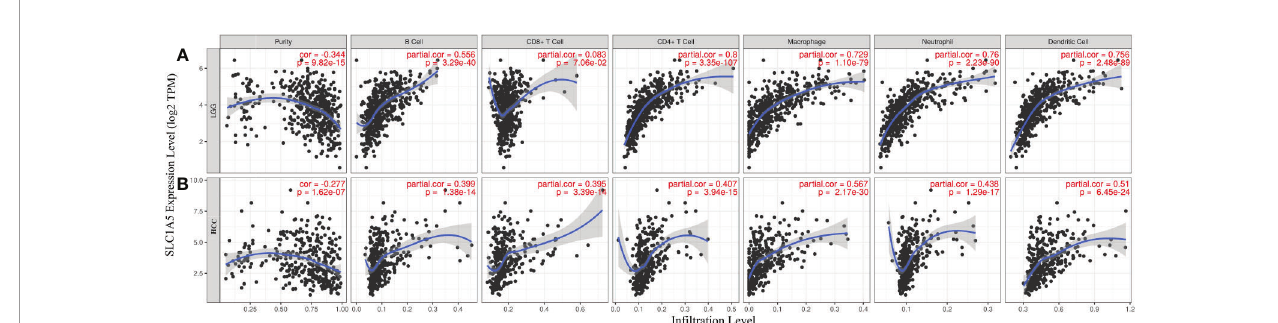
FIGURE 4 | Correlation of SLC1A5 expression with immune in fi ltration in lower-grade glioma (LGG) and hepatocellular carcinoma (HCC). (A) Expression was signi fi cantly negatively correlated with tumor purity and had signi fi cant positive correlations with numbers of in fi ltrating B cells, CD4 + cells, macrophages, neutrophils, and DC in LGG but not CD8 + cells (n = 516). (B) Expression was signi fi cantly negatively related to tumor purity and had signi fi cant positive correlations with numbers of in fi ltrating B cells, CD8 + cells, CD4 + cells, macrophages, neutrophils, and DC in HCC (n =